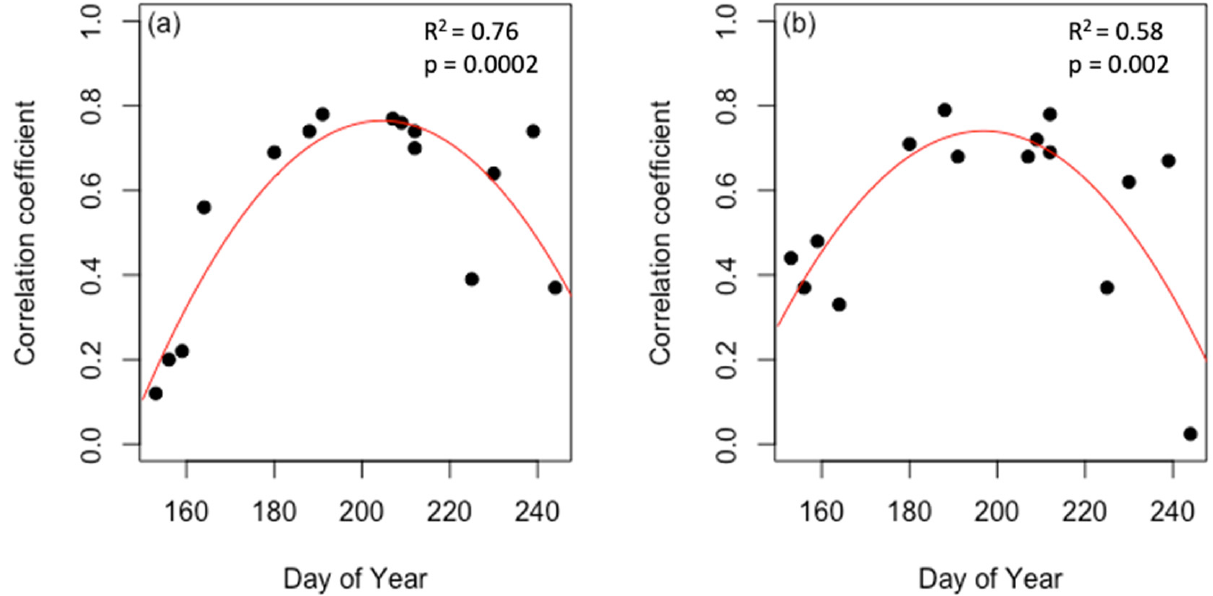
Figure 6. Correlation coefficient plotted against the day of the year for ( a ) the relationship between LST anom and 11:30 am T air(anom) and ( b ) the relationship between 11:30 pm T air(anom) and 11:30 am T air(anom).